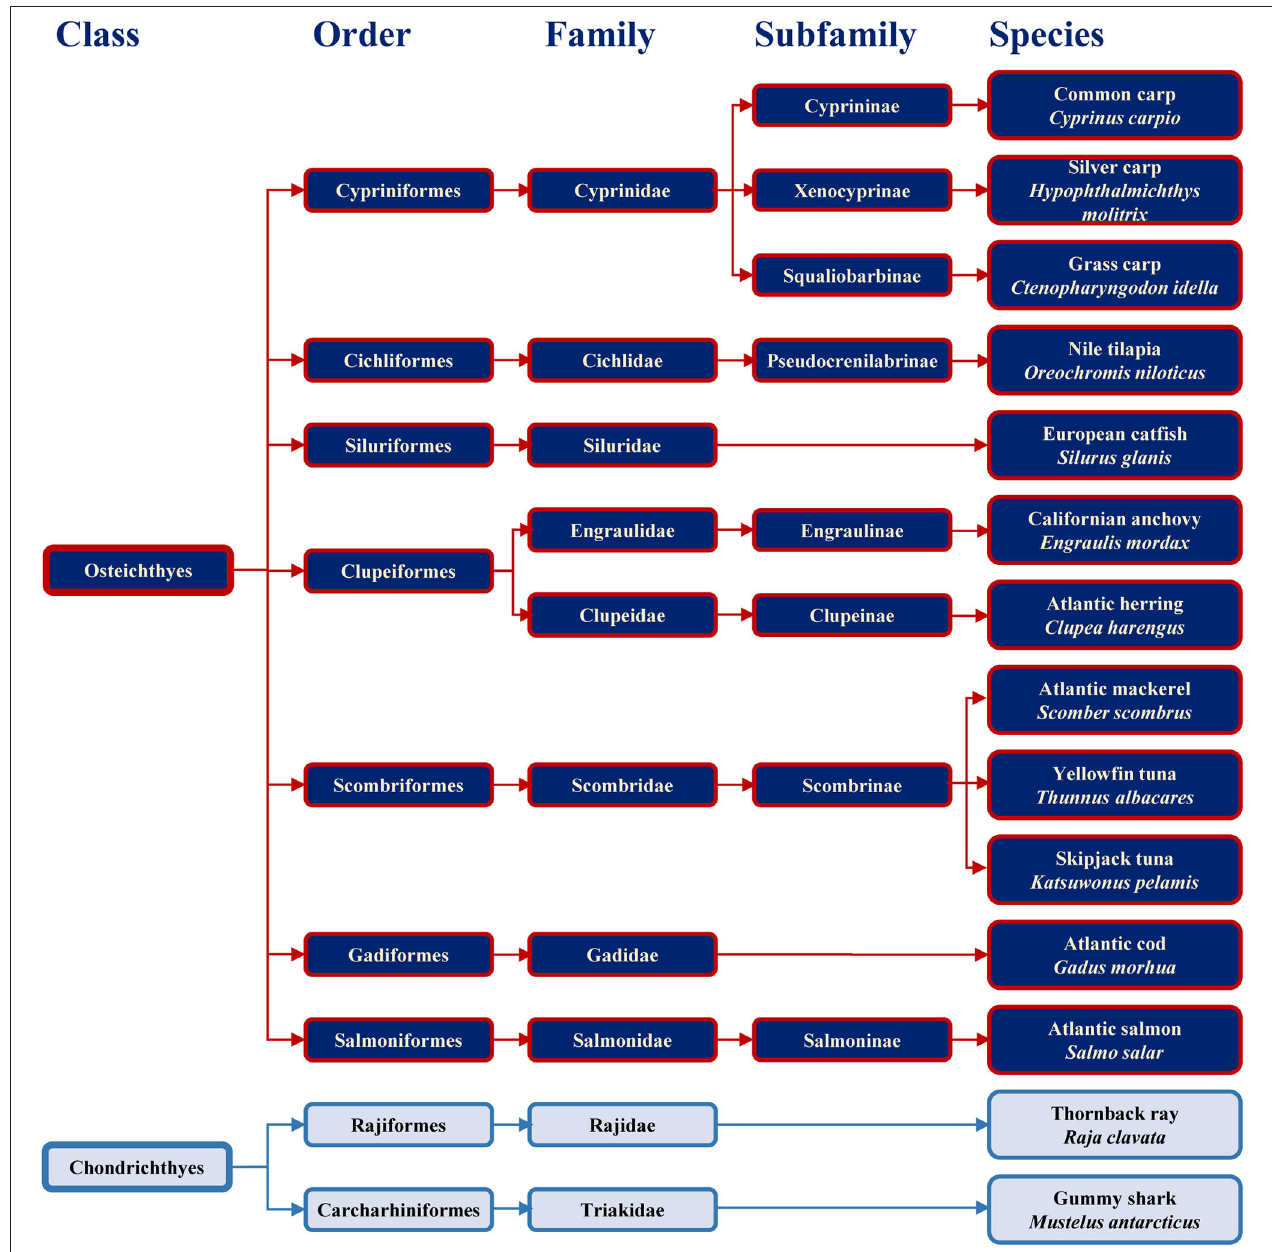
FIGURE 1 | Classification of the main bony and cartilaginous fish species relevant for human consumption.